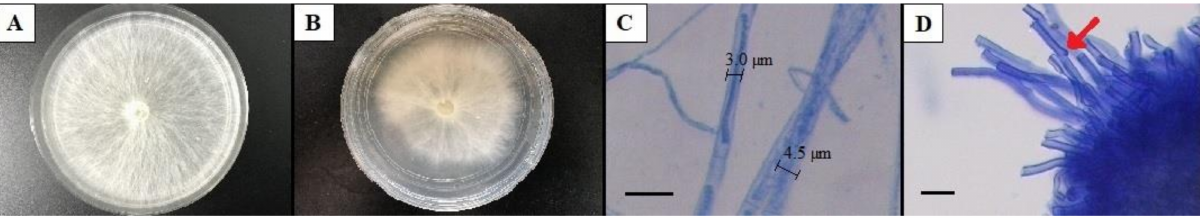
Figure 2. Characteristic of white root rot pathogen: ( A ) colony on PDA on the 8 DAI, ( B ) reverse side on PDA, ( C ) hypha and ( D ) generative hypha (arrow). (Scale bar = 10 µ m; magnification: ×